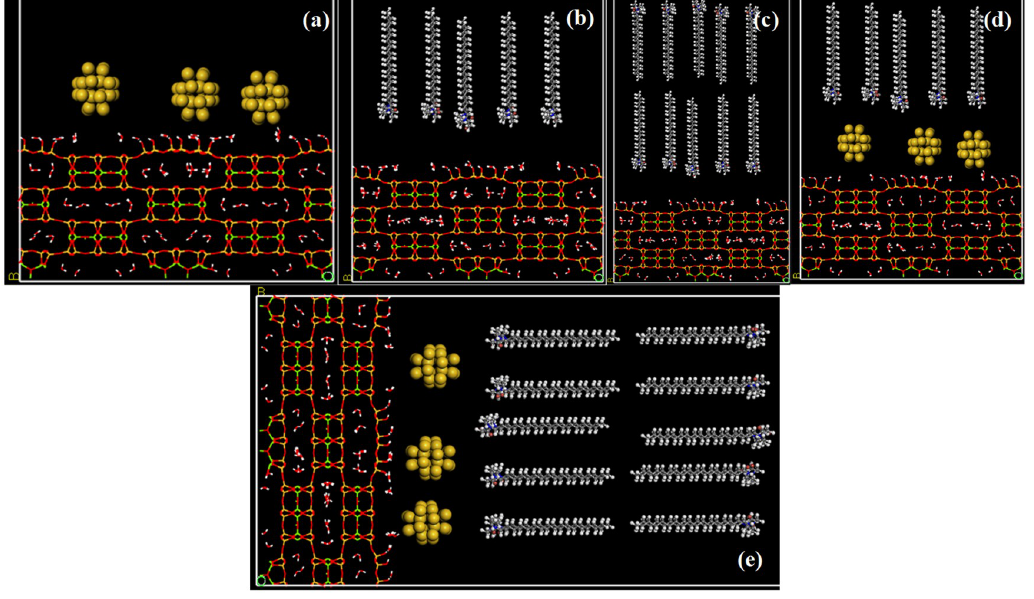
Figure 1. Initial structures of models: gold nanoparticles / sepiolite (AuNPs / SEP) ( a ), monolayer CTAB / SEP ( b ), bilayer CTAB / SEP ( c ), monolayer AuNPs / SEP ( d ), and bilayer AuNPs / SEP ( e ). Red, white, yellow, green, cream yellow, baroque red, blue, and gray represent oxygen, hydrogen, gold, magnesium, silicon, nitrogen, and bromine and carbon atoms, respectively.